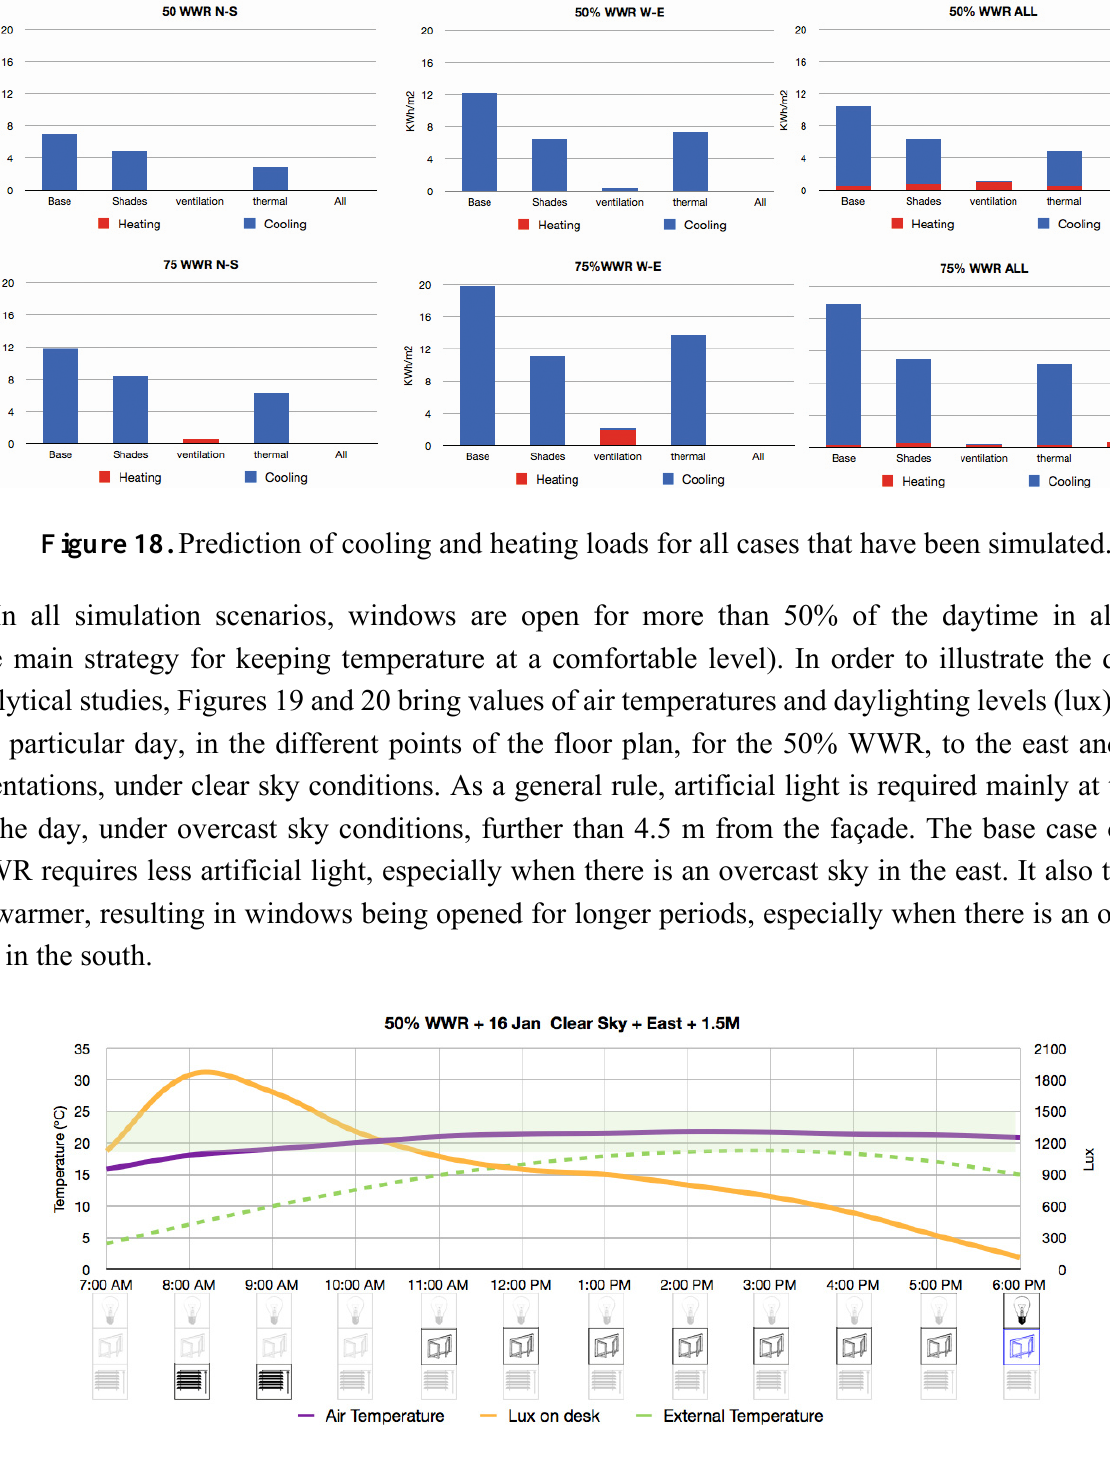
Figure 19. 50% WWR + Clear sky 1.5 m from the EAST